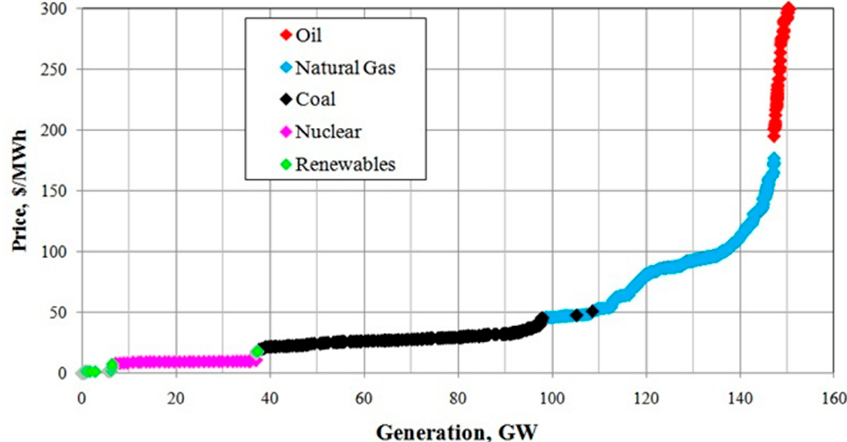
Figure 2. Typical PJM generation stack. Source: The Pennsylvania State University (https://www.e-